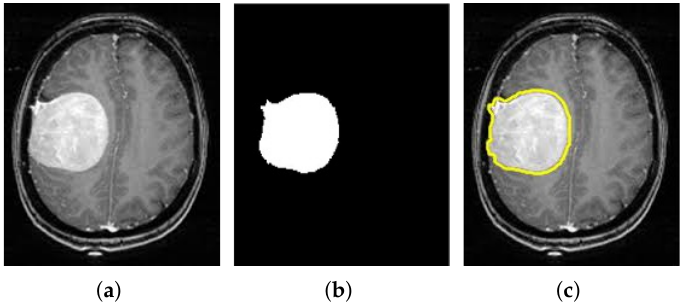
Figure 7. Meningioma brain image. ( a ) Source MRI, ( b ) Segmented tumor image, and ( c ) Extraction of